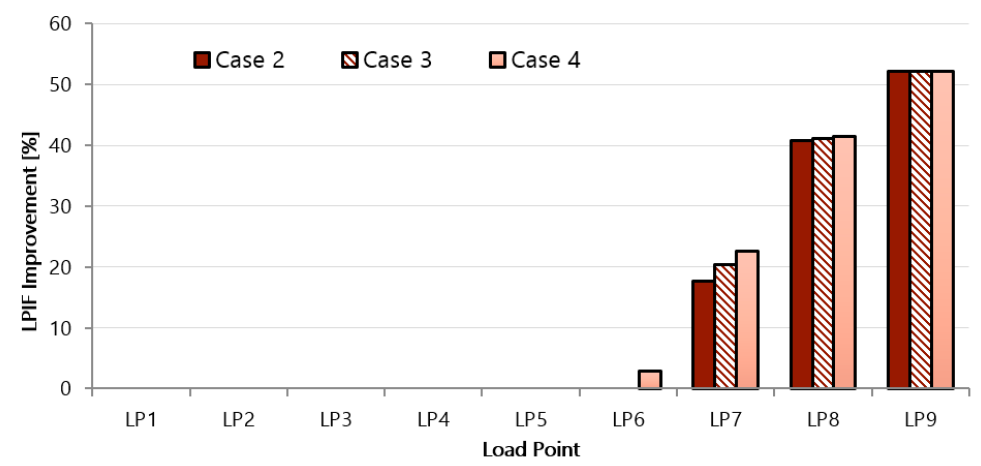
Figure 4. LPIF improvement in load points for case studies compared to Case-1.